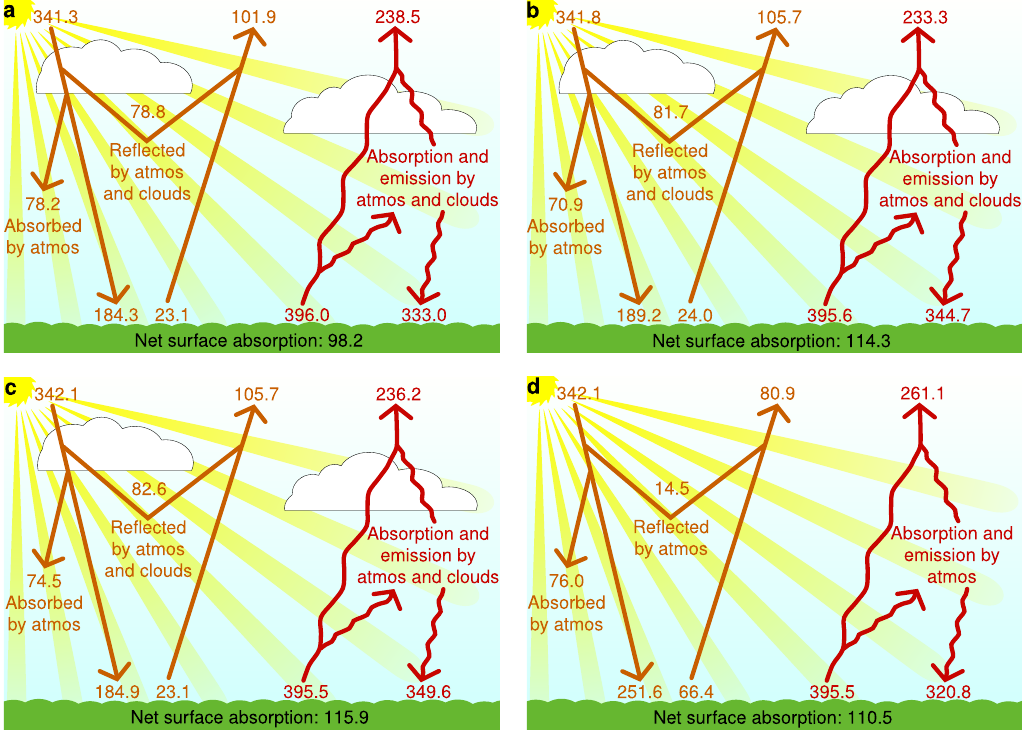
Fig. 5. Comparison of global annual mean energy budgets: two estimates for contemporary climate, (a) Trenberth et al. (2009), based on a composite of data and (b) Zhang et al. (2004), from ISCCP-FD data, compared to models used in this paper, (c) case study with real clouds (d) cloud-free model.